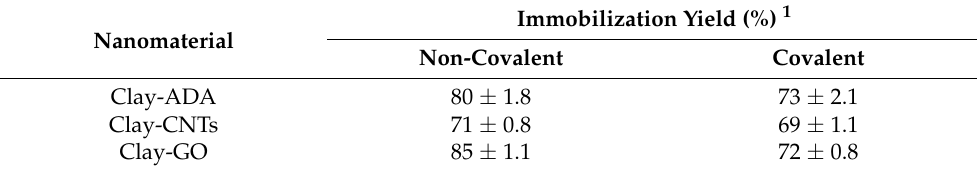
Table 1. Immobilization yield (%) of TvL on hybrid nanomaterials.